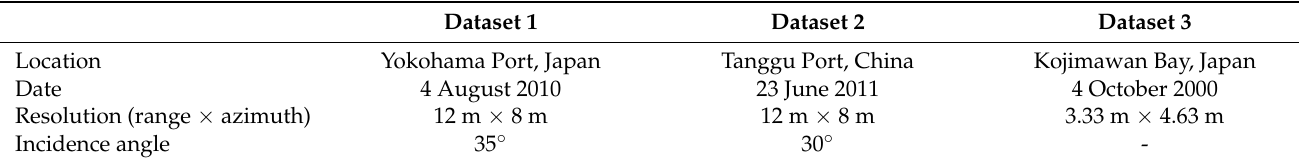
Figure 2. ( a ) Yokohama Port, ( b ) Tanggu Port and ( c ) Kojimawan Bay. The first data set is shown by the log SPAN image, the second and the third data sets are shown by the Pauli pseudo-color image for better visualization. Table 1. Description of the three data sets.